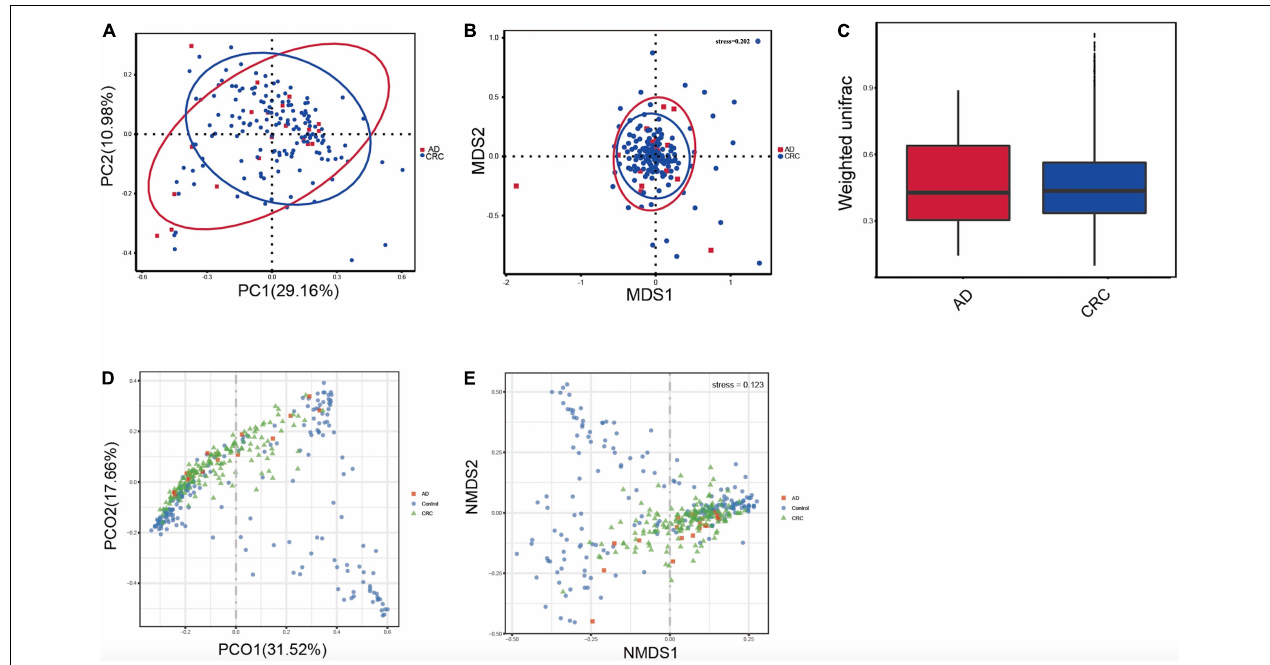
FIGURE 3 | (A) Principal coordinates analysis (PCoA) based on weighted unifrac distance matrix in the AD and CRC group [Pr ( > F) = 0.33]; (B) Non-metric multidimensional scaling (NMDS) based on weighted unifrac distance matrix in the AD and CRC group (stress = 0.202); (C) Beta diversity analysis by weighted UniFrac distance in the AD and CRC group ( P = 0.88); (D) Principal coordinates analysis (PCoA) based on weighted unifrac distance matrix among Control, AD, and CRC group; (E) Non-metric multidimensional scaling (NMDS) based on weighted unifrac distance matrix among Control, AD, and CRC group (stress =